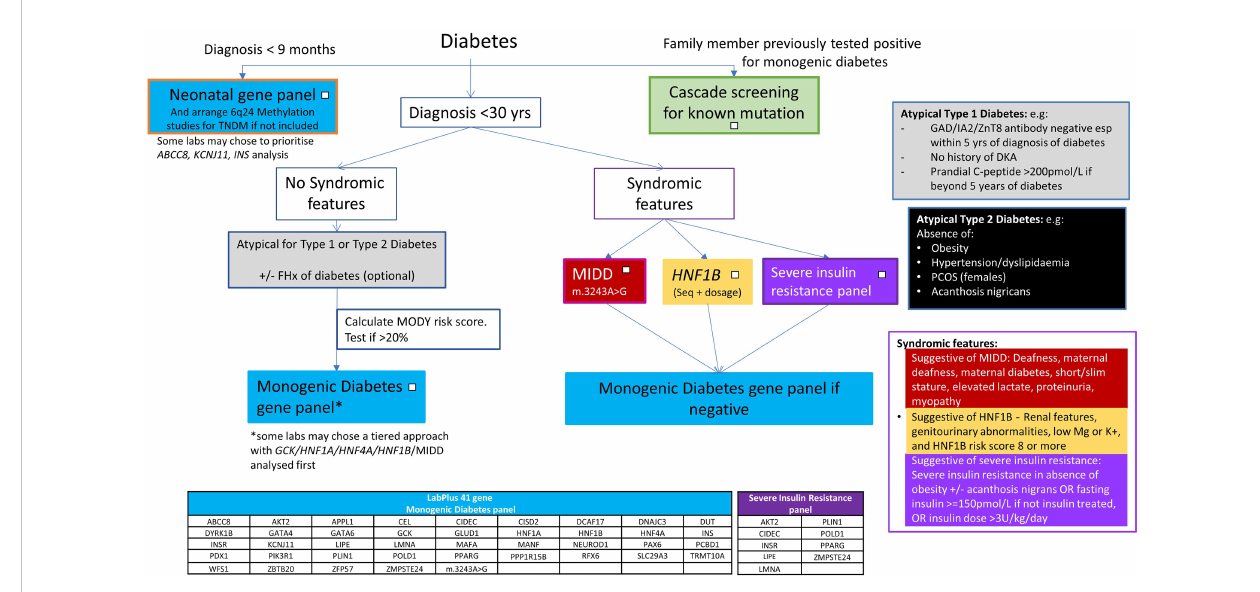
FIGURE 5 New monogenic diabetes testing algorithm for